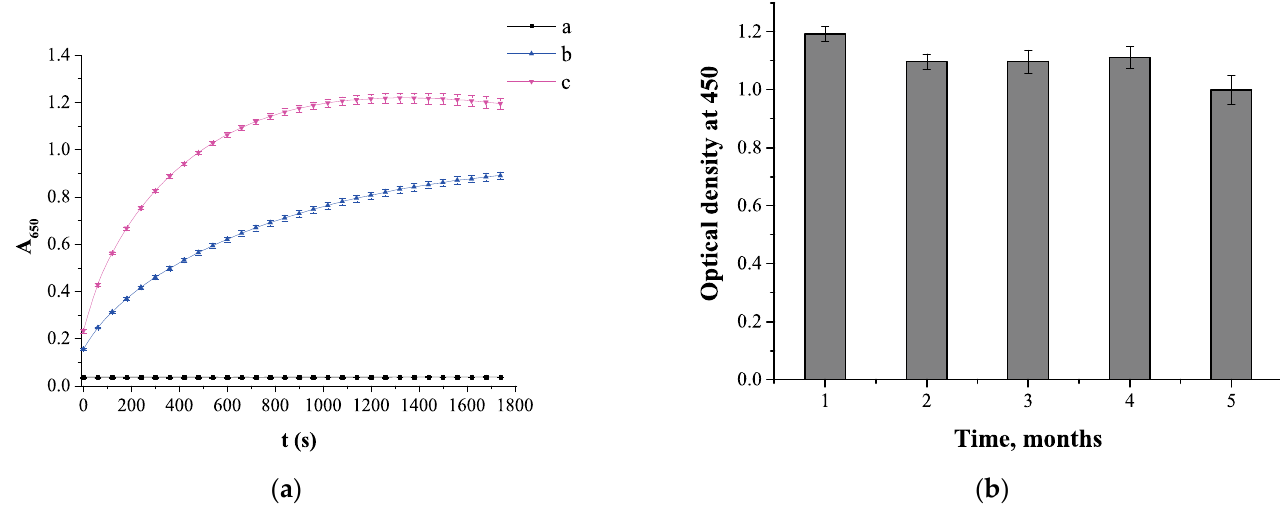
Figure 4. ( a ) Peroxidase-like activity of TA-capped AuNPs: a—substrate mixture, 0.5 M H 2 O 2 + 0.5 mM TMB;